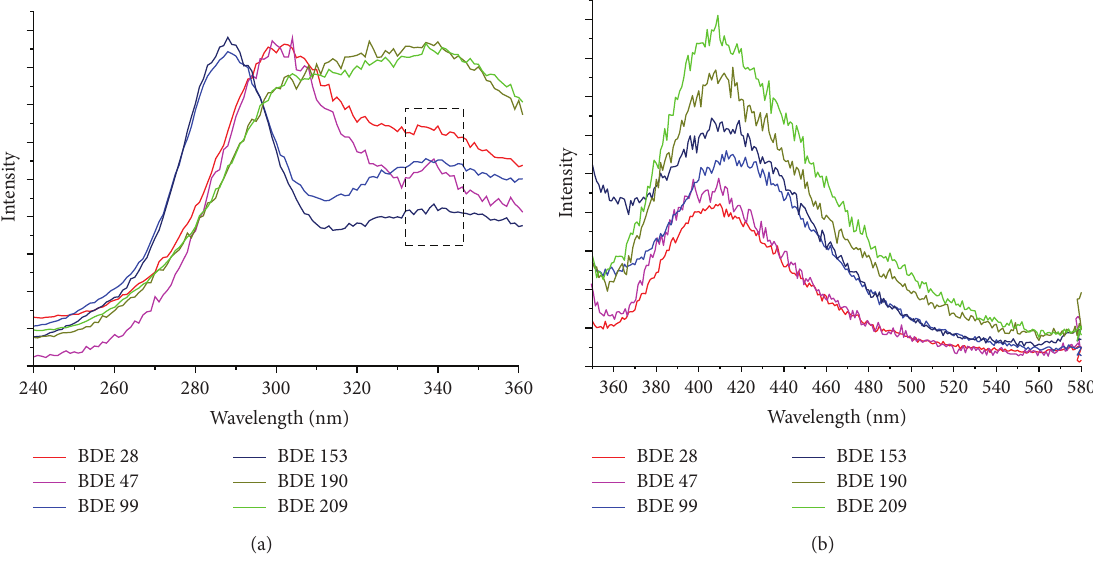
Figure 2: Excitationspectra (a) and emission spectra (b) of BDE 28, BDE 47, BDE 99, BDE 153, BDE 190, and BDE 209. The excitation spectra ) of 440 nm and the emission fluorescence spectra were collected at excitation wavelength were collected at the emission wavelength ( 𝜆 em ) of 302 ( 𝜆 exc